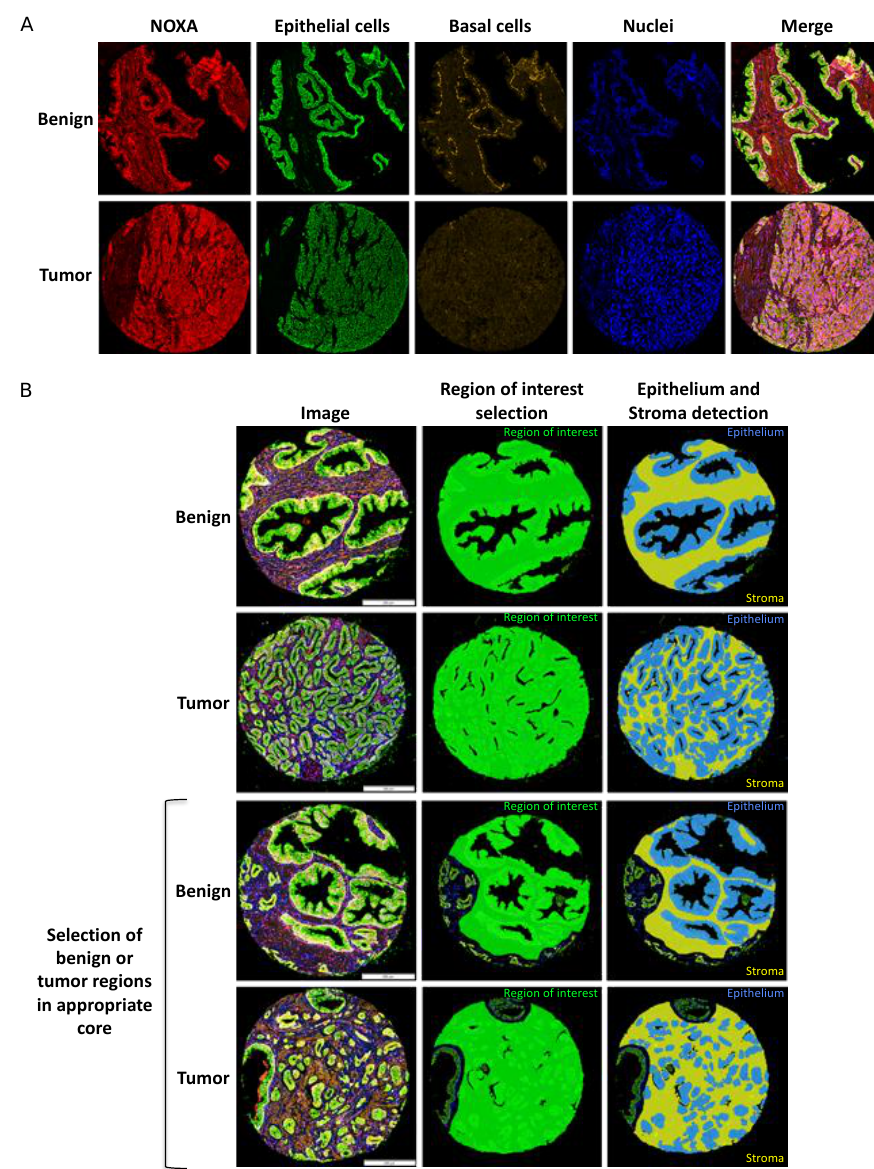
Figure 1. Digital imaging protocol for biomarker analyses. ( A ) Multiplex staining of TMA cores (benign and tumor) to discriminate biomarker expression (NOXA, red), epithelial luminal cells (cytokeratin CK8/18, green), basal cells (p63/CK HMW, yellow) and nuclei (DAPI, blue). Merge: superimposed images. ( B ) Representative analyses of biomarker detection in different cellular compartments using VisiomorphDP software. Images in the first column represent cores after IF staining. The second and third columns illustrate the use of specific compartmental algorithms within VisiomorphDP software: region of interest (green), epithelium (blue) and stroma (yellow). For each sub-compartment, the MFI for each specific biomarker was calculated.